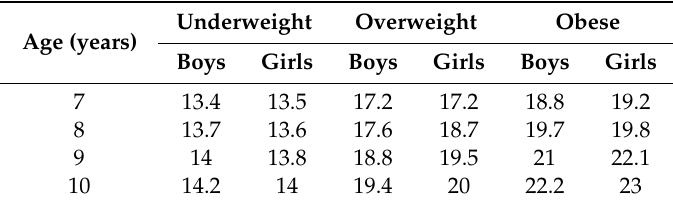
Table 1. Cuto ff Points for BMI by Age and Gender